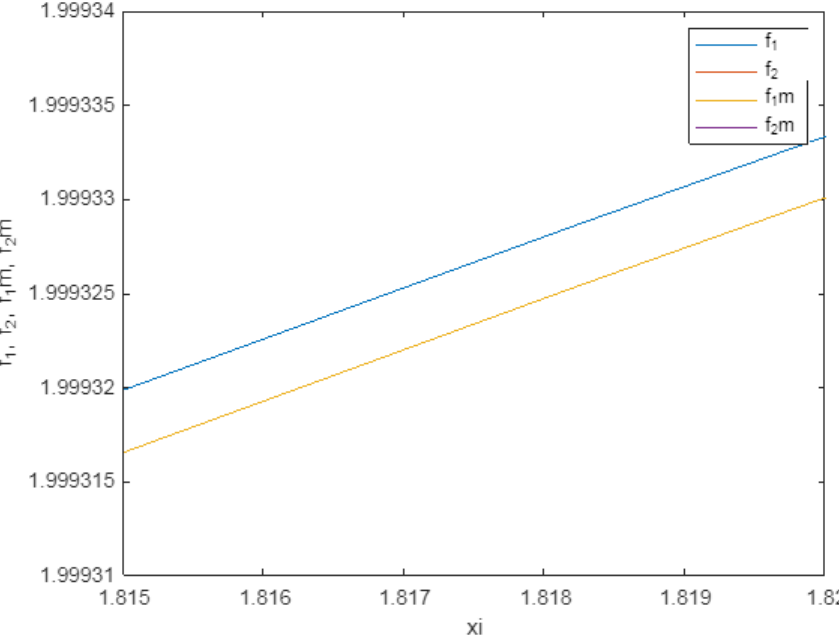
Figure 2. TW profiles for a + λ = 4 with n = 0.9, m = 0.1. For the sake of simplicity, r = 2. Note the lower solution ϕ 1 m as the solution for the problem (20). The numerical exercise was performed for an integration interval ( 0,100 ) ; nonetheless, the interval was cut for representation purposes. Note that f 1 and f 2 represent ϕ 1 and ϕ 2 solutions to (19) while f 1 m and f 2 m are solutions to